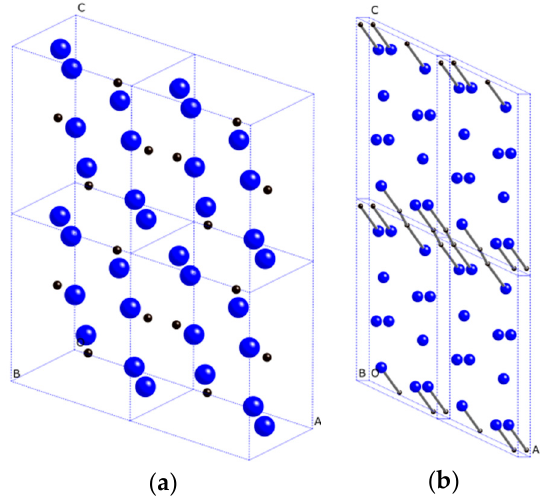
Figure 1. Crystal structures of Ca 2 C. ( a ) Pnma -Ca 2 C; ( b ) C 2/ m -Ca 2 C. The black and blue spheres represent C and Ca atoms, respectively.